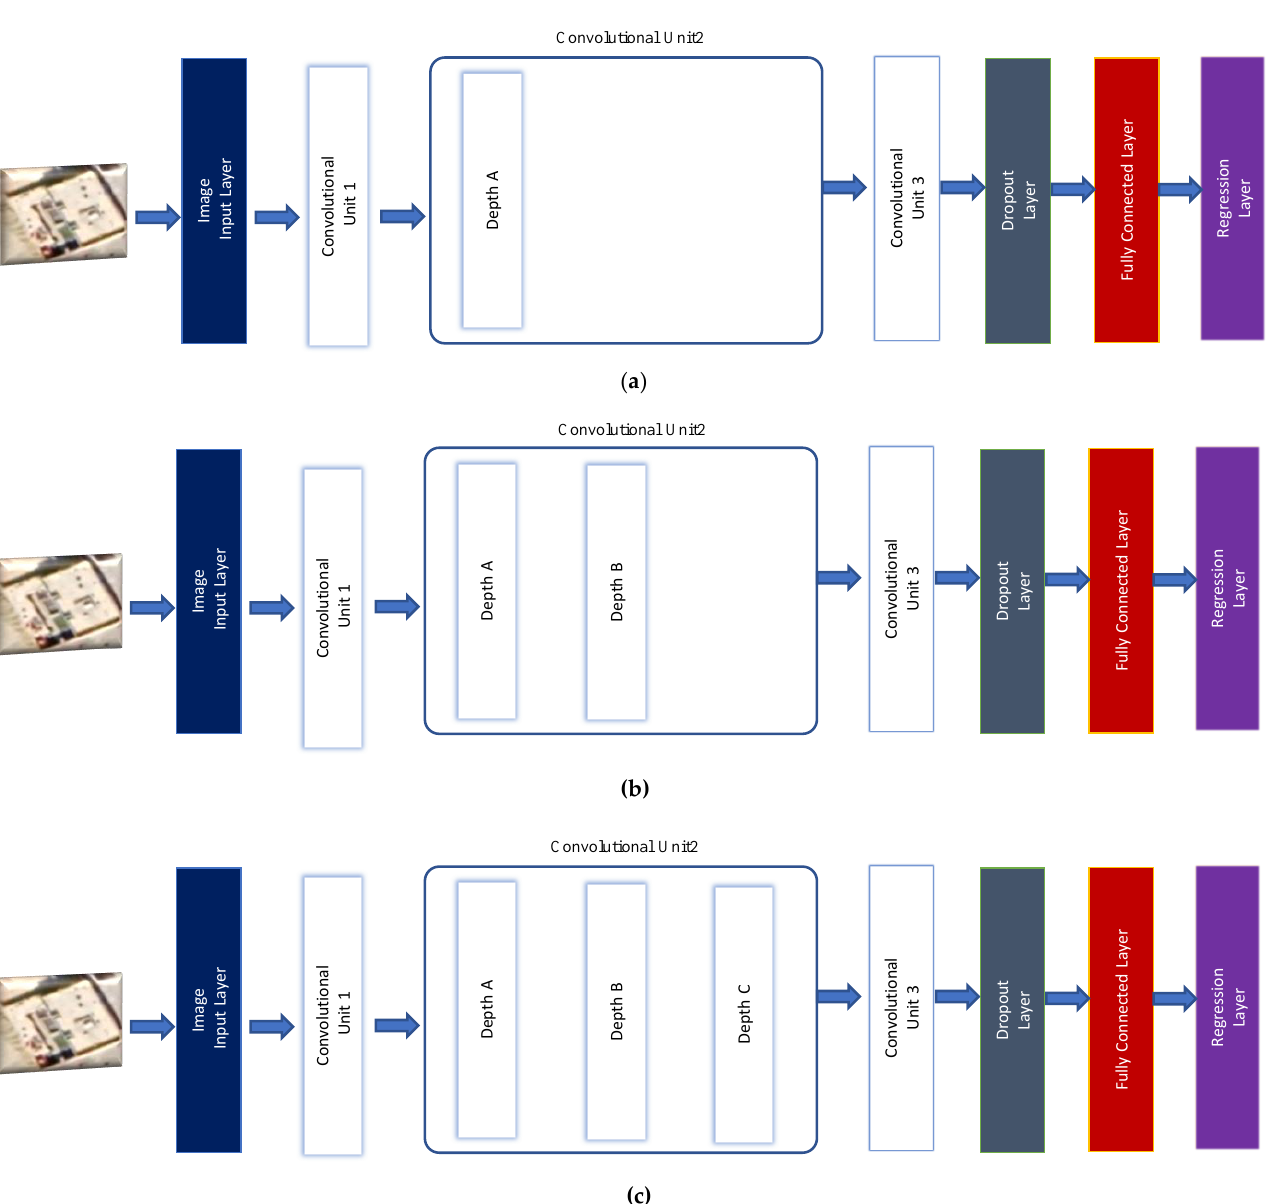
Figure 6. The proposed DCRN with three architectures ( a ) depth A, ( b ) depth B, and ( c ) depth